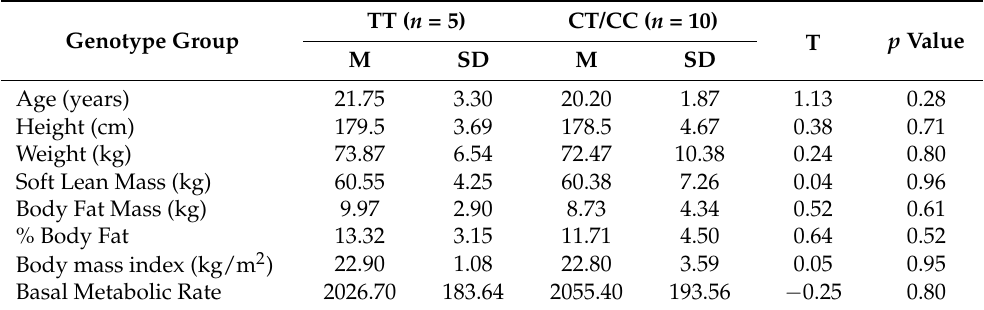
Table 1. Physical characteristics of the subjects with ADORA2A C allele ( n = 10) and TT genotype ( n =